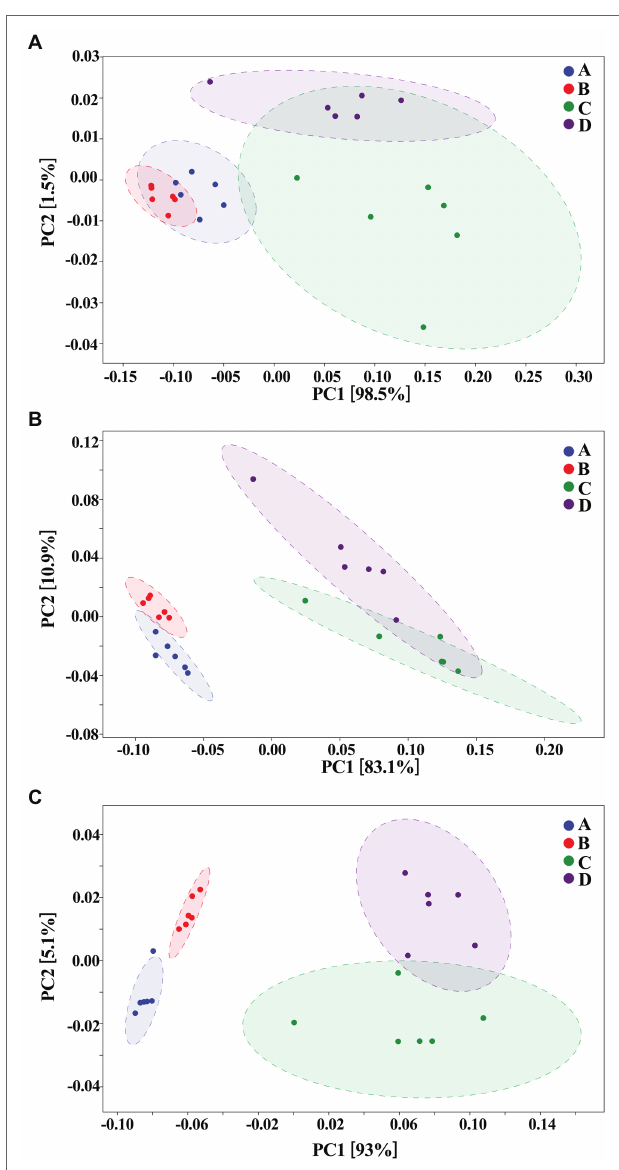
FIGURE 9 | Principal components analysis (PCA; n = 6) at (A) phylum, (B) genus, and (C) species levels. A: Healthy; B: healthy + ZnONP; C: ADHD; and D: ADHD +